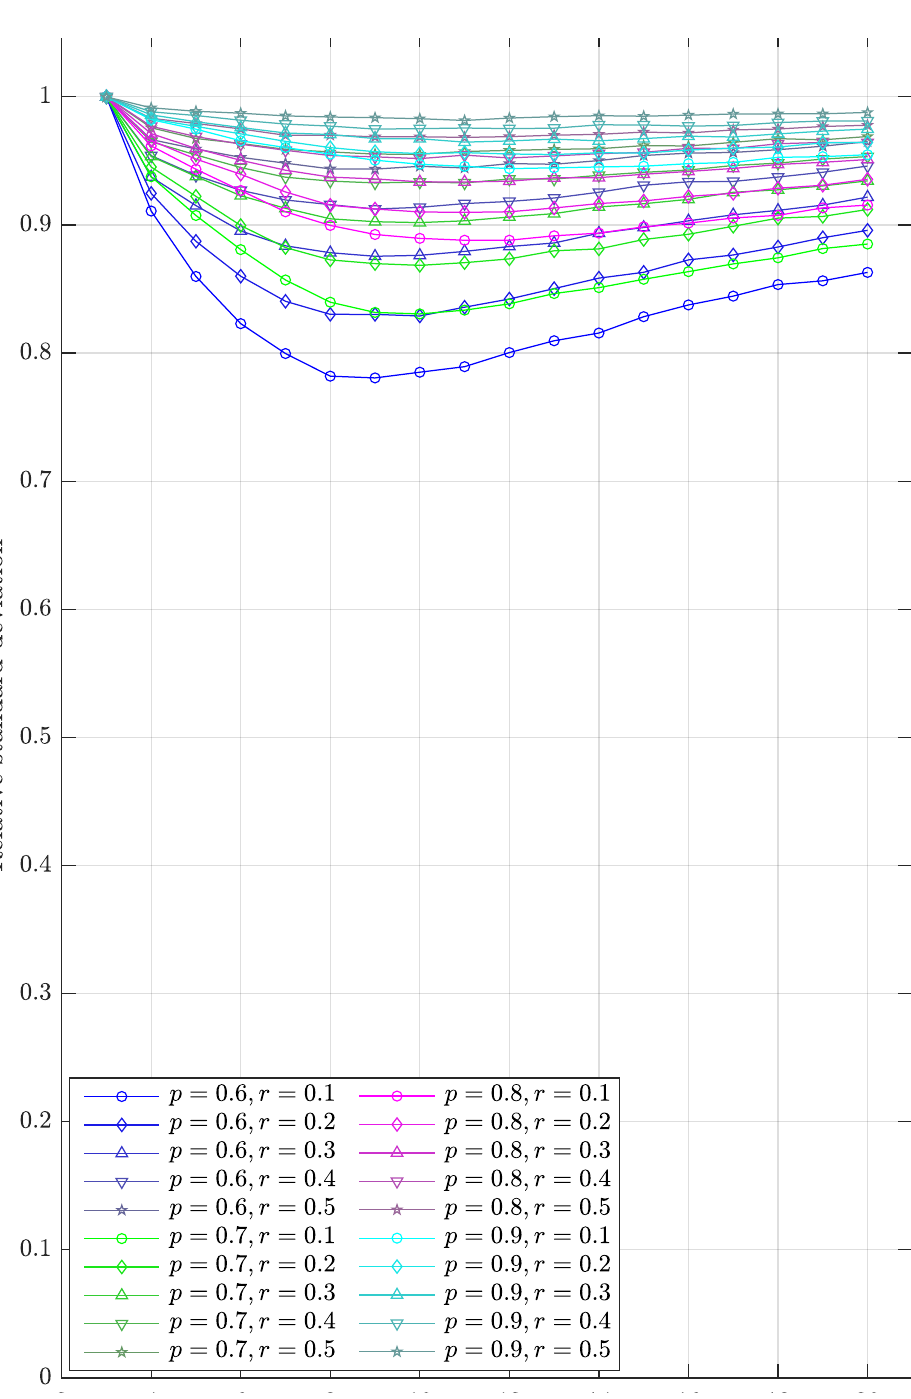
Figure 8. Relative standard deviation (heteroskedastic rms over homoskedastic rms) of the curvature κ for p T = 10,GeV/ c , λ = π /4 and all 20 combinations of p and r in the range 3 ≤ n ≤